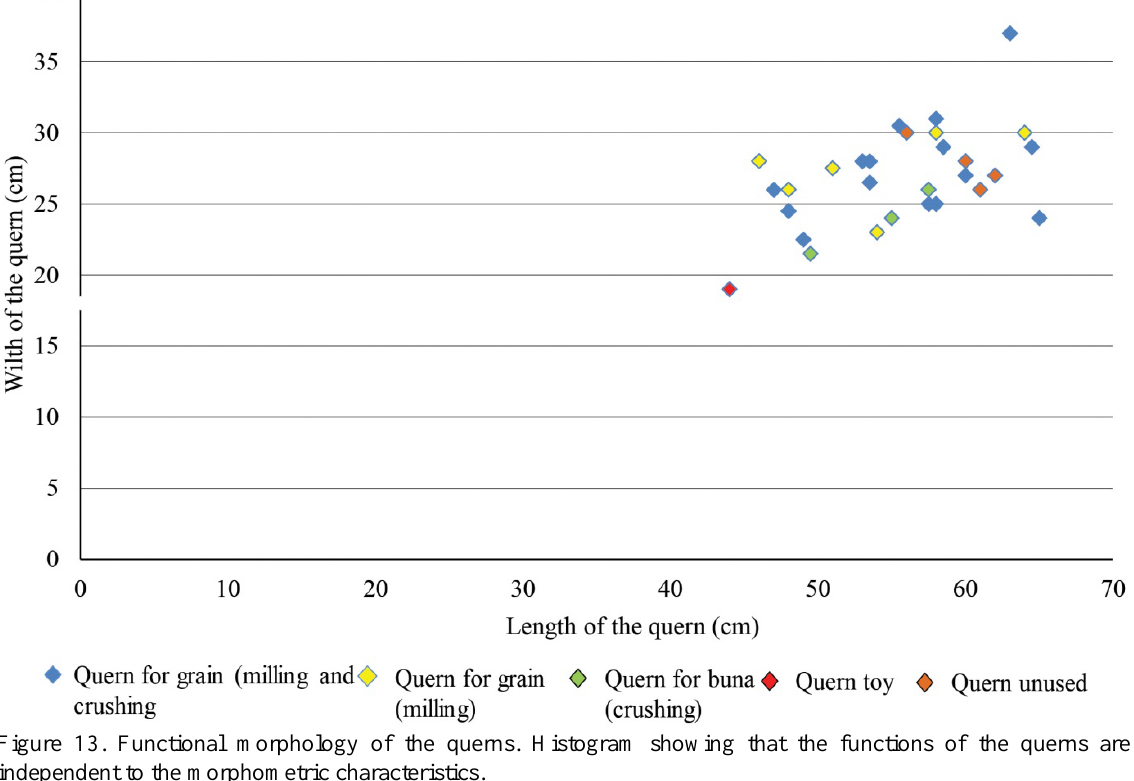
Figure 13. Functional morphology of the querns. Histogram showing that the functions of the querns are independent to the morphometric